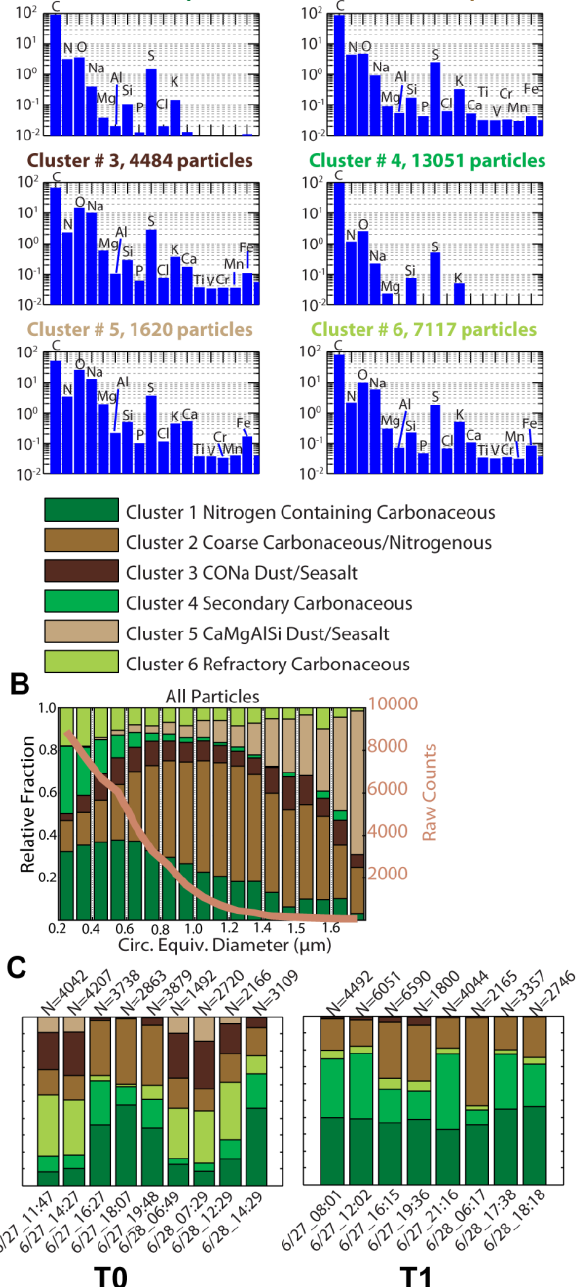
Figure 6. Results from K-means cluster analysis 1